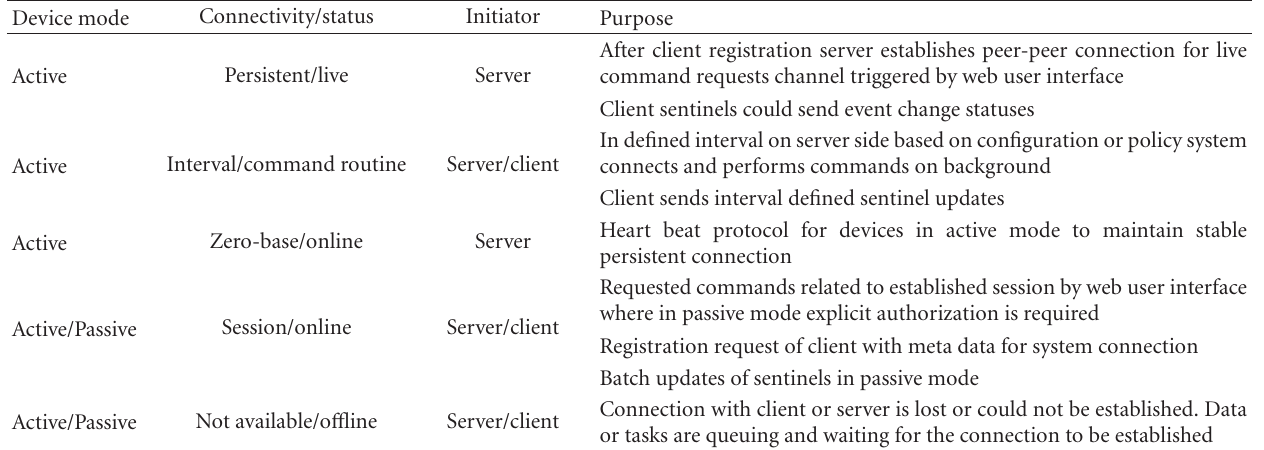
Table 2: Table of connection